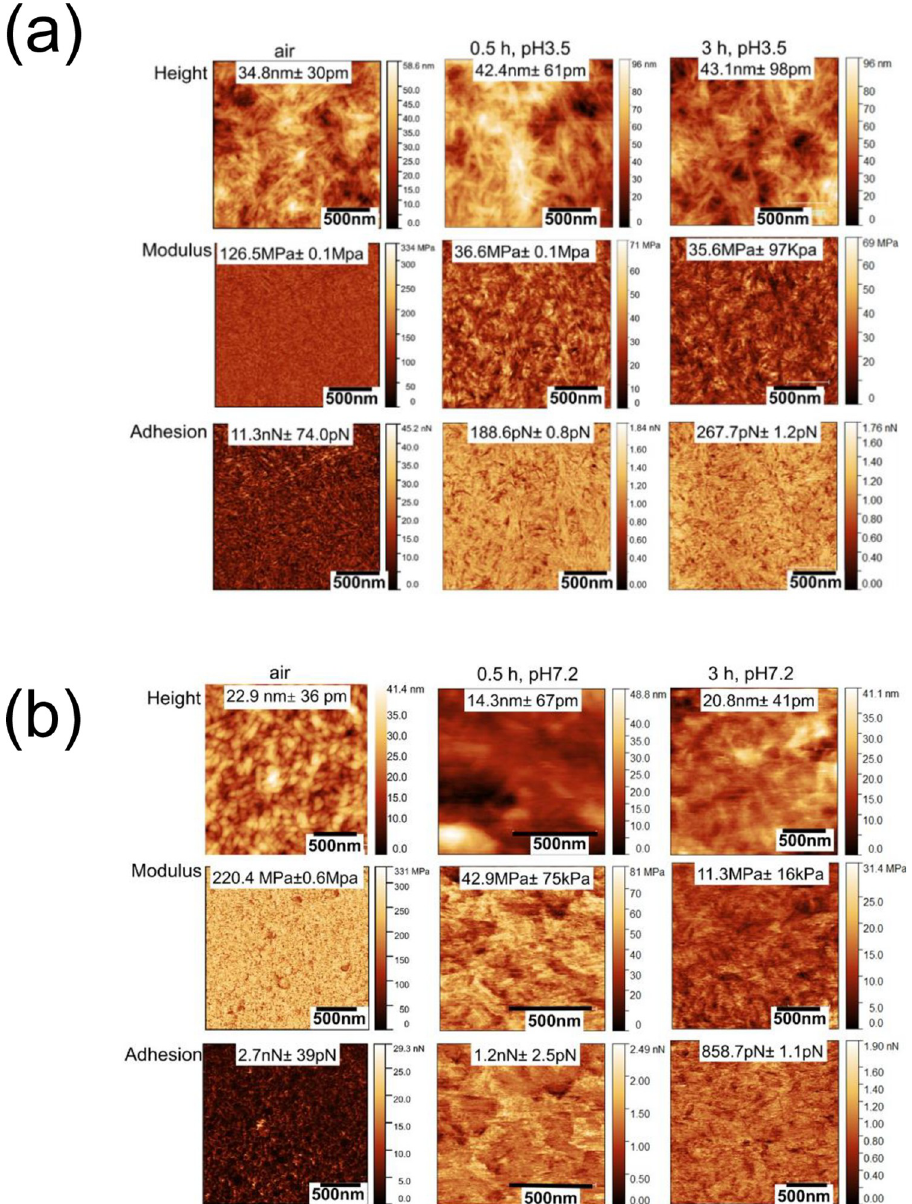
Fig 2. Sequential PFQNM images of CNCs obtained in air and then in PBS buffer after 30 minutes after 3 hours of immersion at pH 3.5 (panel (a)) and pH 7.2 (panel (b)). (scale bar: 500 nm).